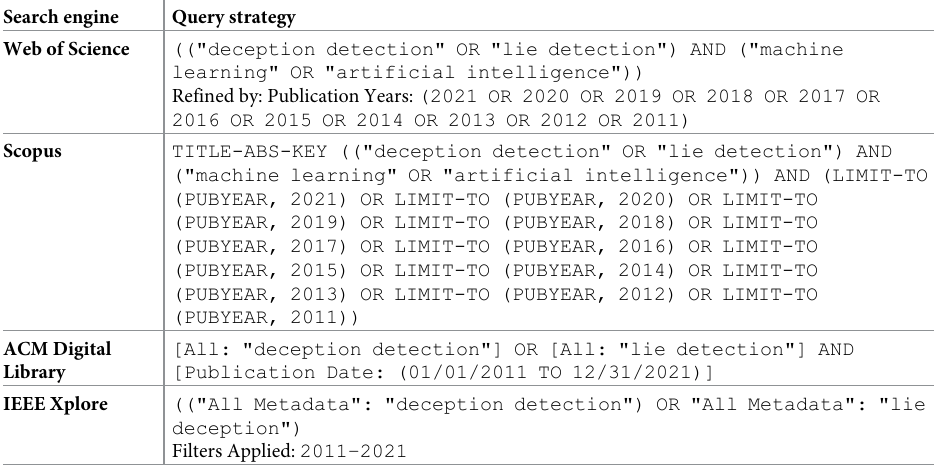
Table 1. Search queries issued to different academic search engines. Search